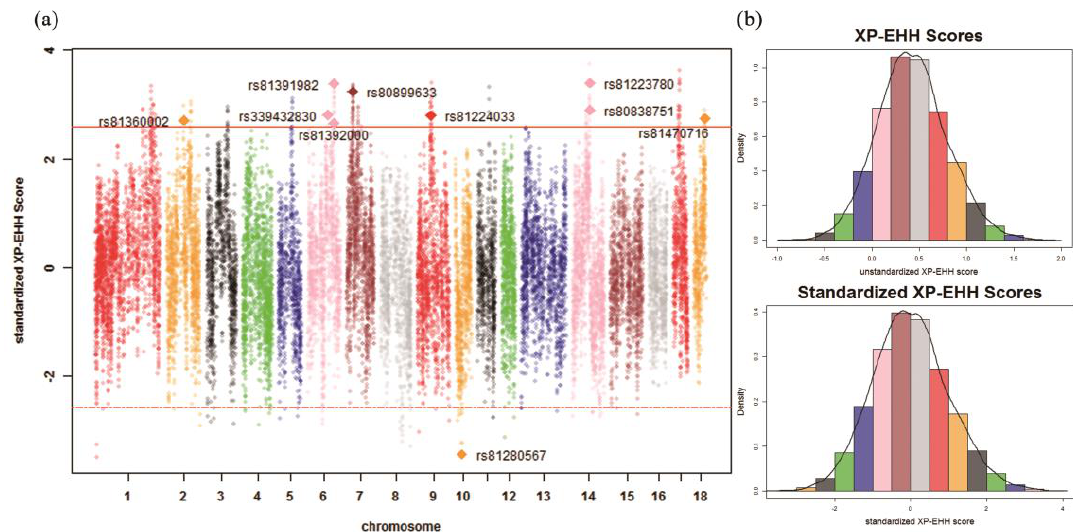
Figure 3. Cross-population extended haplotype homozygosity (XP-EHH) scores across all autosomes in the Ding’an and Tunchang / Baoshan groups. ( a ) Genome-wide distribution of signatures of selection detected by XP-EHH across all autosomes in the Ding’an and Tunchang / Baoshan groups. The SNPs shown as diamonds are the significant SNPs detected simultaneously by two methods. The red lines show the threshold p -value (0.01). ( b ) The distribution of unstandardized XP-EHH scores and standardized XP-EHH scores across all autosomes in the Ding’an and Tunchang / Baoshan group s.